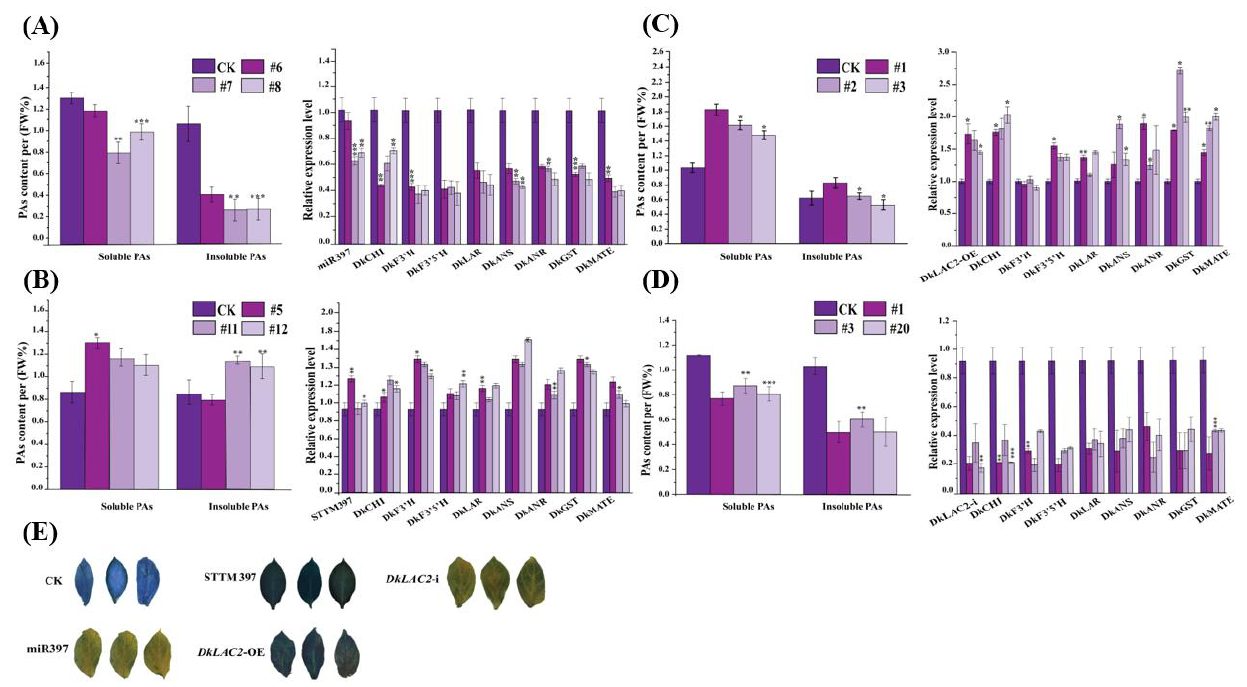
Figure 5. Overexpression of Pre-miR397, STTM-miR397, DkLAC2 -OE, and DkLAC2 -i with a stable transformation system in ‘Gongcheng Shuishi’ persimmon. Quantitative measurement of transcript level of genes in the PAs biosynthesis pathway and PAs contents variation in ‘ Gongcheng Shuishi ’ persimmon transgenic lines of expressing by ( A ) DkmiR397, ( B ) STTM397, ( C ) DkLAC2, and ( D ) DkLAC2 -i. ( E ) The DMACA staining of regenerated transgenic lines leaves of DkmiR397-OE, DkSTTM-397, DkLAC2- OE, and DkLAC2 -i. CHI: chalcone isomerase; F 3′ H: flavonoid 3′ -hydroxylase; F 3′5′ H: flavonoid 3′5′ -hydroxylase; ANS: anthocyanidin synthase; ANR: anthocyanidin reductase; LAR: leucoanthocyanidin reductase; GST: glutathione S -transferase; MATE: multi-drug and toxic compound extrusion transporter. Errors bars indicate SEs from three biological replicates ( n =3). Asterisks above the bars indicate values determined by Student’s t -test to be significantly different from the control (* p < 0.05, ** p < 0.01, *** p < 0.001).